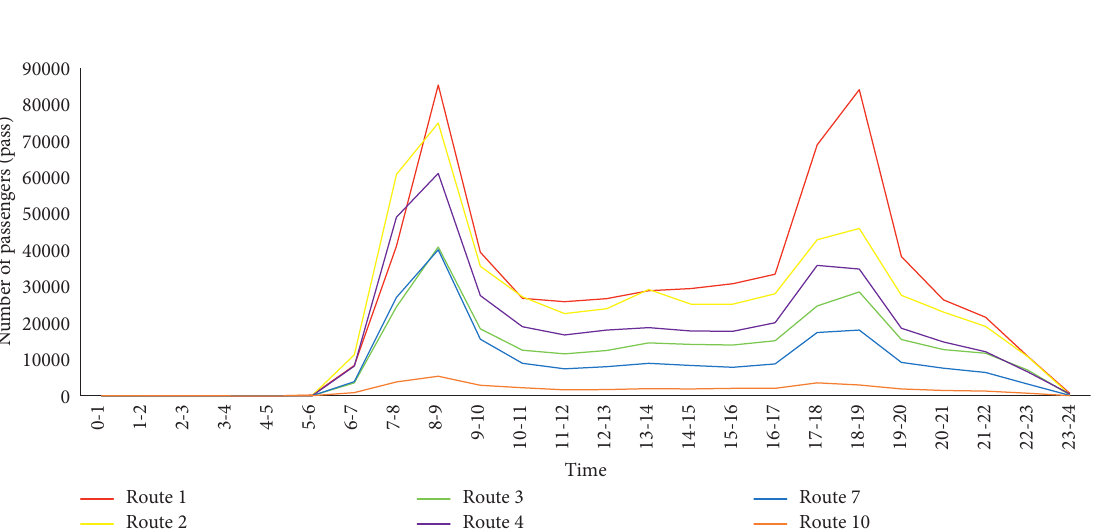
Figure 3: The Chengdu Metro network.